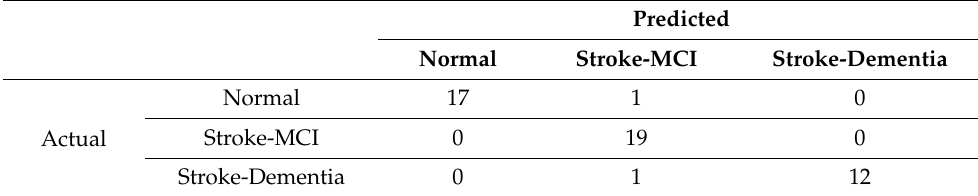
Table 14. The confusion matrix of the highest accuracy.